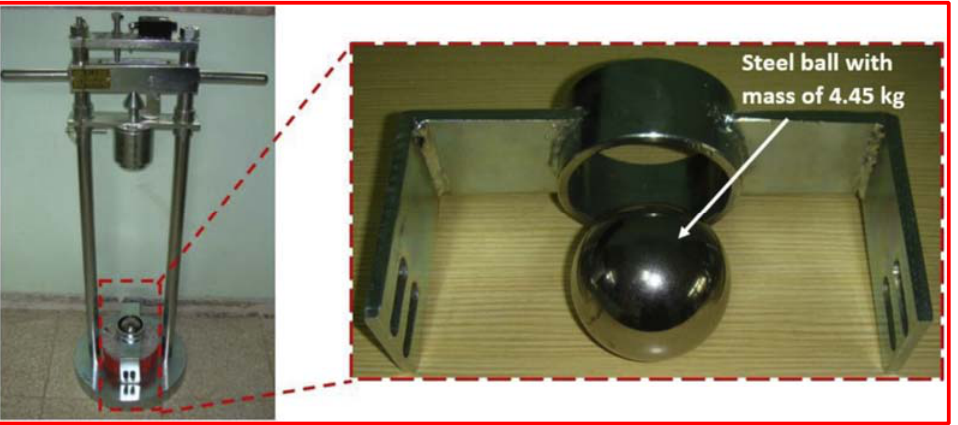
Figure 1. ACI Committee drop weight test (Adapted from [15]).